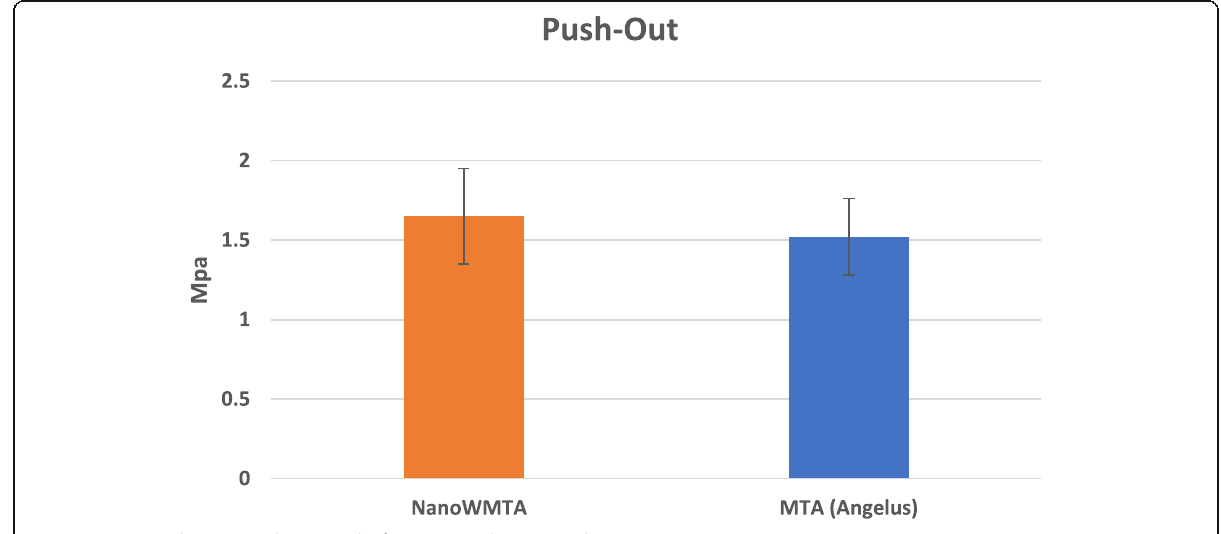
Fig. 1 Histogram showing push-out results for NMTA and MTA Angelus